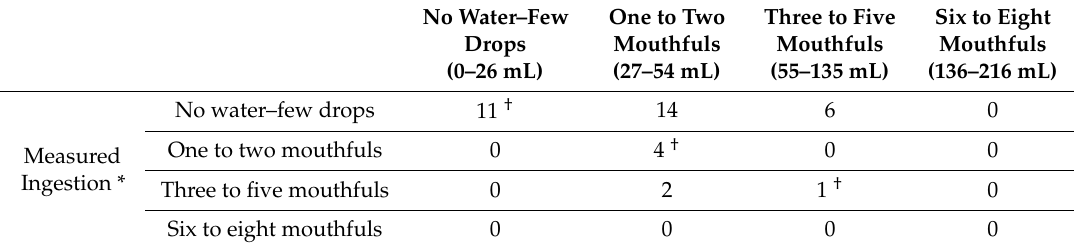
Table 2. Number of swimmers reporting and actually ingesting pool water amounts within each volume range listed on the questionnaire ( n =